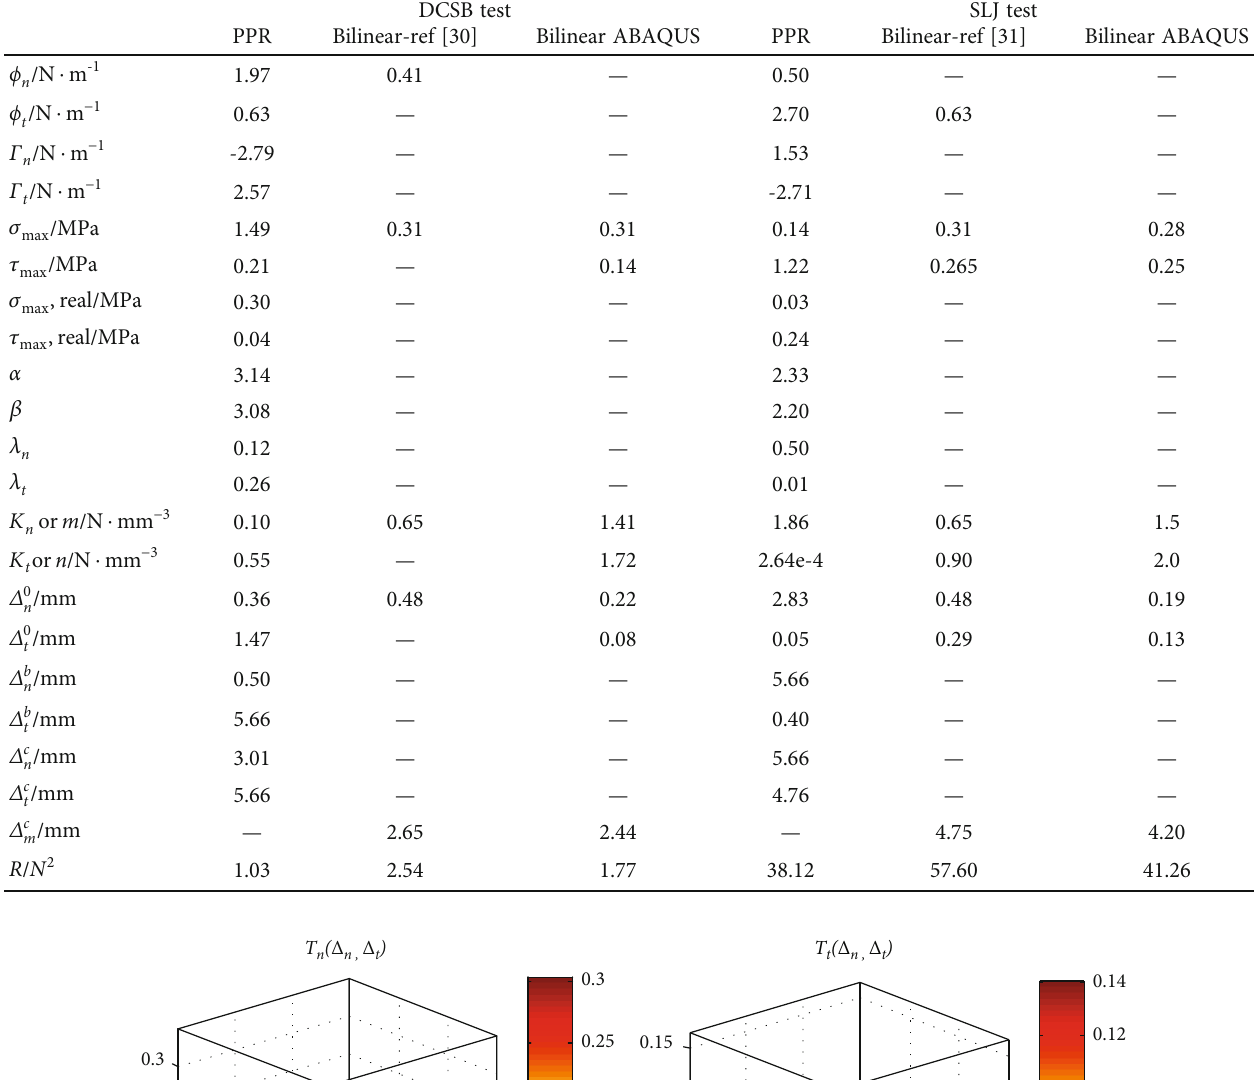
Table 3: Parameters obtained by inversion for PPR CZM, bilinear CZM in ref [30, 31], and bilinear CZM in ABAQUS in DCSB and SLJ test.